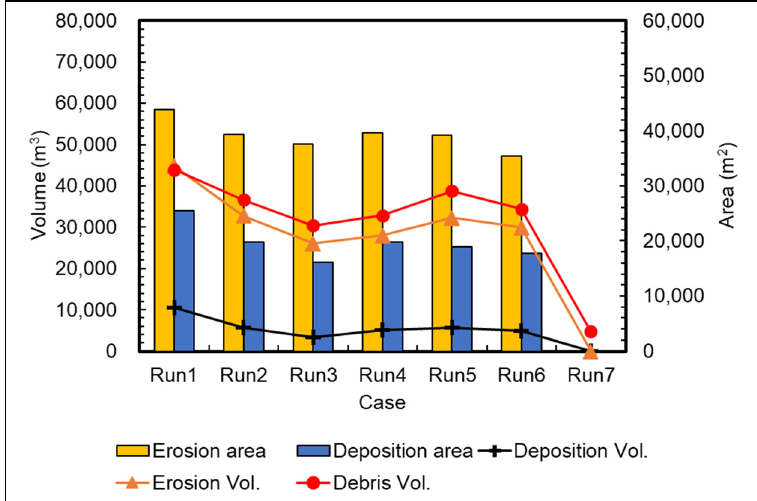
Figure 7. Final results of entrainment phenomena in all the simulations.